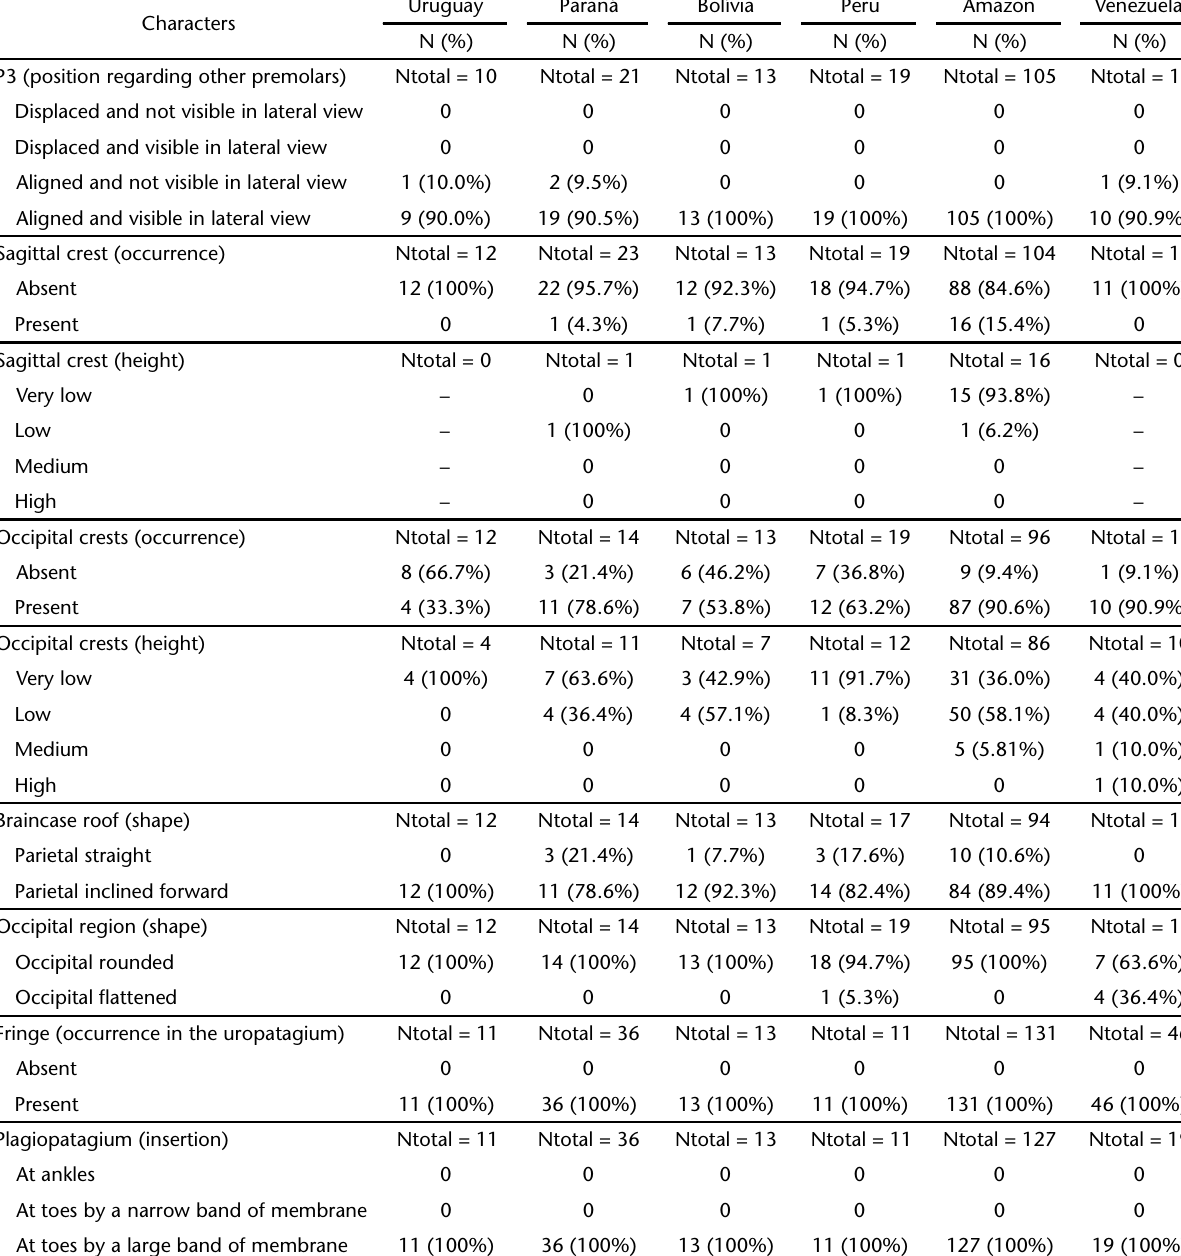
Table III. Occurrence and distribution of selected qualitative characters for geographic samples (groups 1–6) of Myotis albescens